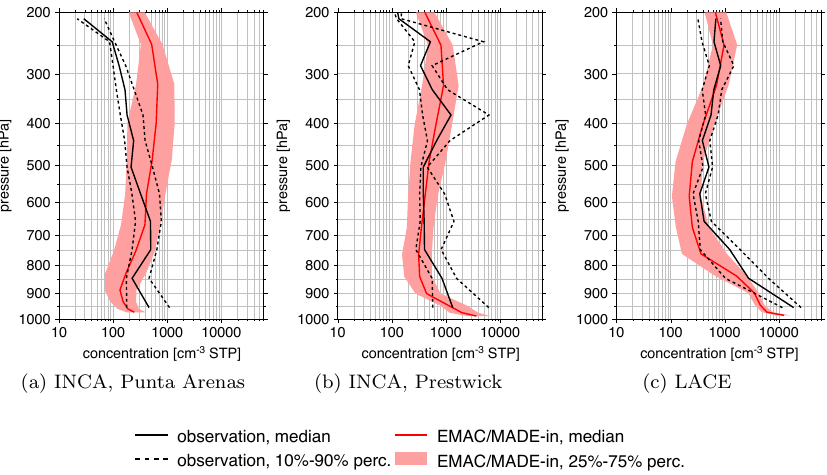
Fig. 8. Vertical profiles of the number concentration (converted to STP conditions: 273K, 1013hPa) of aerosol particles larger than 5nm as measured by Minikin et al. (2003) during INCA over Punta Arenas (Chile) in March-April 2000 and over Prestwick (Scotland) in October 2000 ( a and b , respectively) and by Petzold et al. (2002) during LACE over central Europe in August 1998 (c) and corresponding model